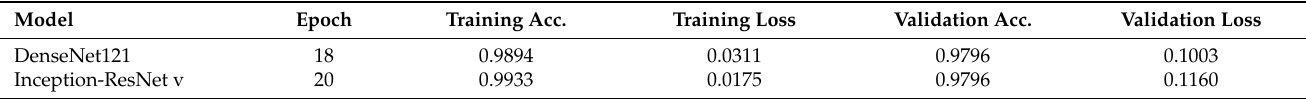
Table A1. Accuracy statistics and epochs of final segmentation maps per model after additional training with OpenStreetMap (OSM) data. The epoch with the highest validation accuracy was chosen as a representation for each model. Accuracy and loss values were rounded to the fourth decimal